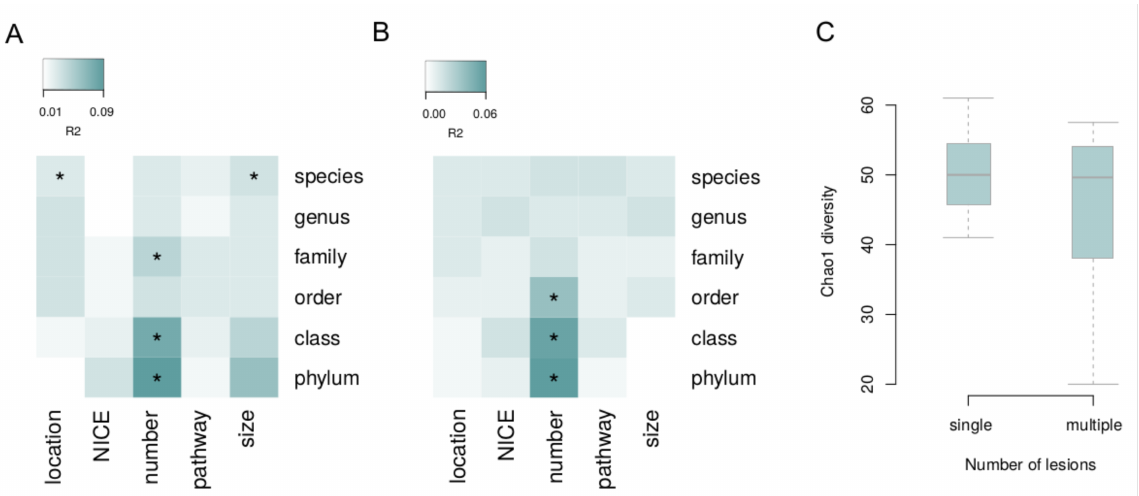
Figure 2. Associations of overall microbiome composition with lesion characteristics. Beta diversity was analyzed at different taxonomic levels. ( A ) Tumor biopsy. ( B ) Stool. ( C ) Biopsy: alpha diversity is linked to the number of lesions. Asterisks denote significant associations (FDR < 0.05).